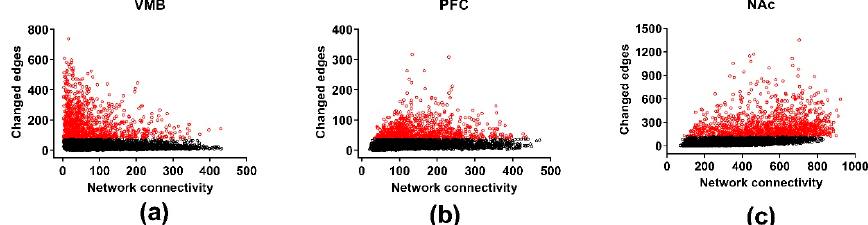
Figure 4. Differential wiring in the methamphetamine high drinking (MAHDR) and methamphetamine low drinking (MALDR) lines. To facilitate comparison across regions, the connectivity and number of edges are computed only for the genes shared in common across the brain regions. The numbers of changed edges for the coexpression networks are shown in ( a ) for the ventral midbrain (VMB), ( b ) for the prefrontal cortex (PFC) and ( c ) for the nucleus accumbens (NAc). Genes significantly enriched in changed edges, relative to other genes in the same network, are depicted in red.